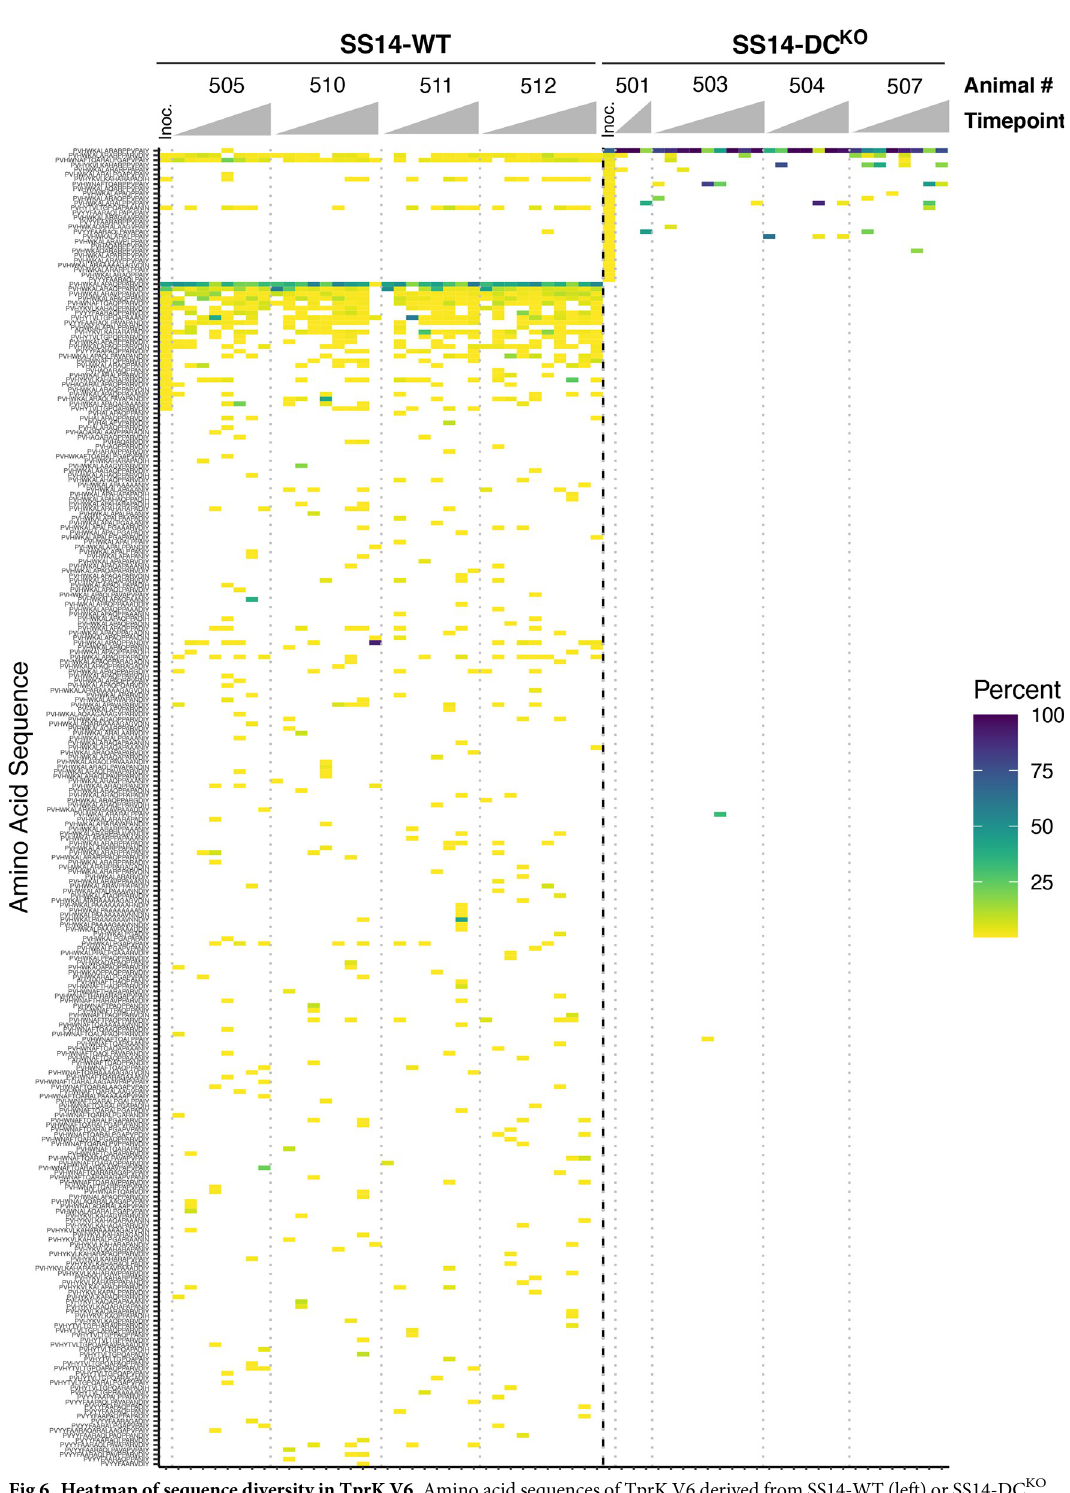
Fig 6. Heatmap of sequence diversity in TprK V6. Amino acid sequences of TprK V6 derived from SS14-WT (left) or SS14-DC KO (right), separated by a bold dotted line. Each column represents the sequences present in a single biopsy for a single animal at a particular timepoint, with biopsy timepoints arranged left to right and animals separated by light dotted lines. Color scale represents the prevalence of each amino acid sequence within each sample. Inoculum samples are labeled “Inoc”. Sequences are arranged in order of decreasing prevalence in SS14-DC KO inoculum, then by SS14-WT inoculum. Missing samples did not yield data. Interactive